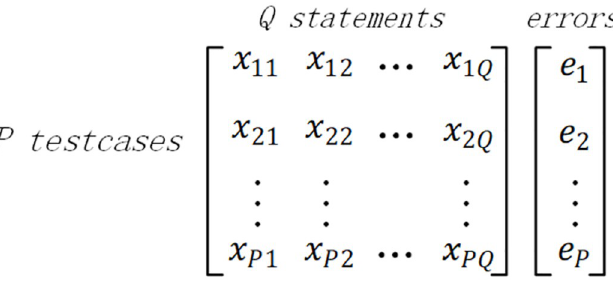
Fig 2. The coverage and results of P executions. Shown in the figure is a matrix based on program dynamic execution information. One dimension of the matrix is the executable statement Q , and the other dimension is the test case T . Each test case corresponding to an execution result is represented by an element e in the matrix represents whether a certain test case executes a certain statement, which is distinguished by 1 and 0.